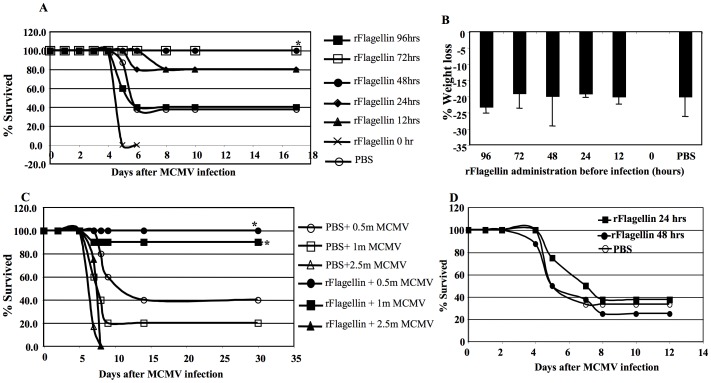
Prophylactic rflagellin administration protected mice from lethal mCMV infection.A. A total of 5 groups WT B6 mice were treated with 25 µg rflagellin/mouse i.p 96, 72, 48, 24 or 0 hours before a lethal dose (2×LD50, 1×106 pfu/mouse i.p) of mCMV infection. Control mice were treated with PBS only 48 hours before the same lethal dose of mCMV infection. Infected mice were monitored every day to record for mortality. The % survival recorded until day 17 after mCMV infection is shown. The symbol “*” indicates the p value<0.05, Log Rank Test of groups rflagellin 48 hrs or 72 hrs vs PBS-treated group. B. The % weight loss measured on day 5 after mCMV infection. All mice receiving rflagellin at 0 hours after mCMV infection died before day 5 after mCMV infection and the % weight loss data of this group was not available. 5–10 mice were used per group. C. WT B6 mice were treated with a single dose of rflagellin 25 µg/mouse or 0.2 ml PBS i.p. 48 hours later mice were infected either with 0.5×106, 1×106 or 2.5×106 mCMV pfu/mouse i.p. The % survival on day 28 after mCMV infection is presented. 10 mice were used per group. The % survival recorded until day 17 after mCMV infection is shown. The symbol “*” indicates the p value<0.05, Log Rank Test of while compared with the survival data of rflagellin-treated mice vs corresponding mCMV infection dose in PBS-treated mice. 5–10 mice were used per group. D. WT B6 mice were infected with 0.5×106 mCMV pfu/mouse i.p. A single dose of rflagellin (25 µg/mouse) was injected i.p 24 or 48 hours after mCMV infection. Control mice were injected with 0.2 ml PBS i.p 24 hours after mCMV infection. Survival of mice after mCMV infection was monitored each day and % survived mice until 12 days after infection is presented. 6–8 mice were used per group.